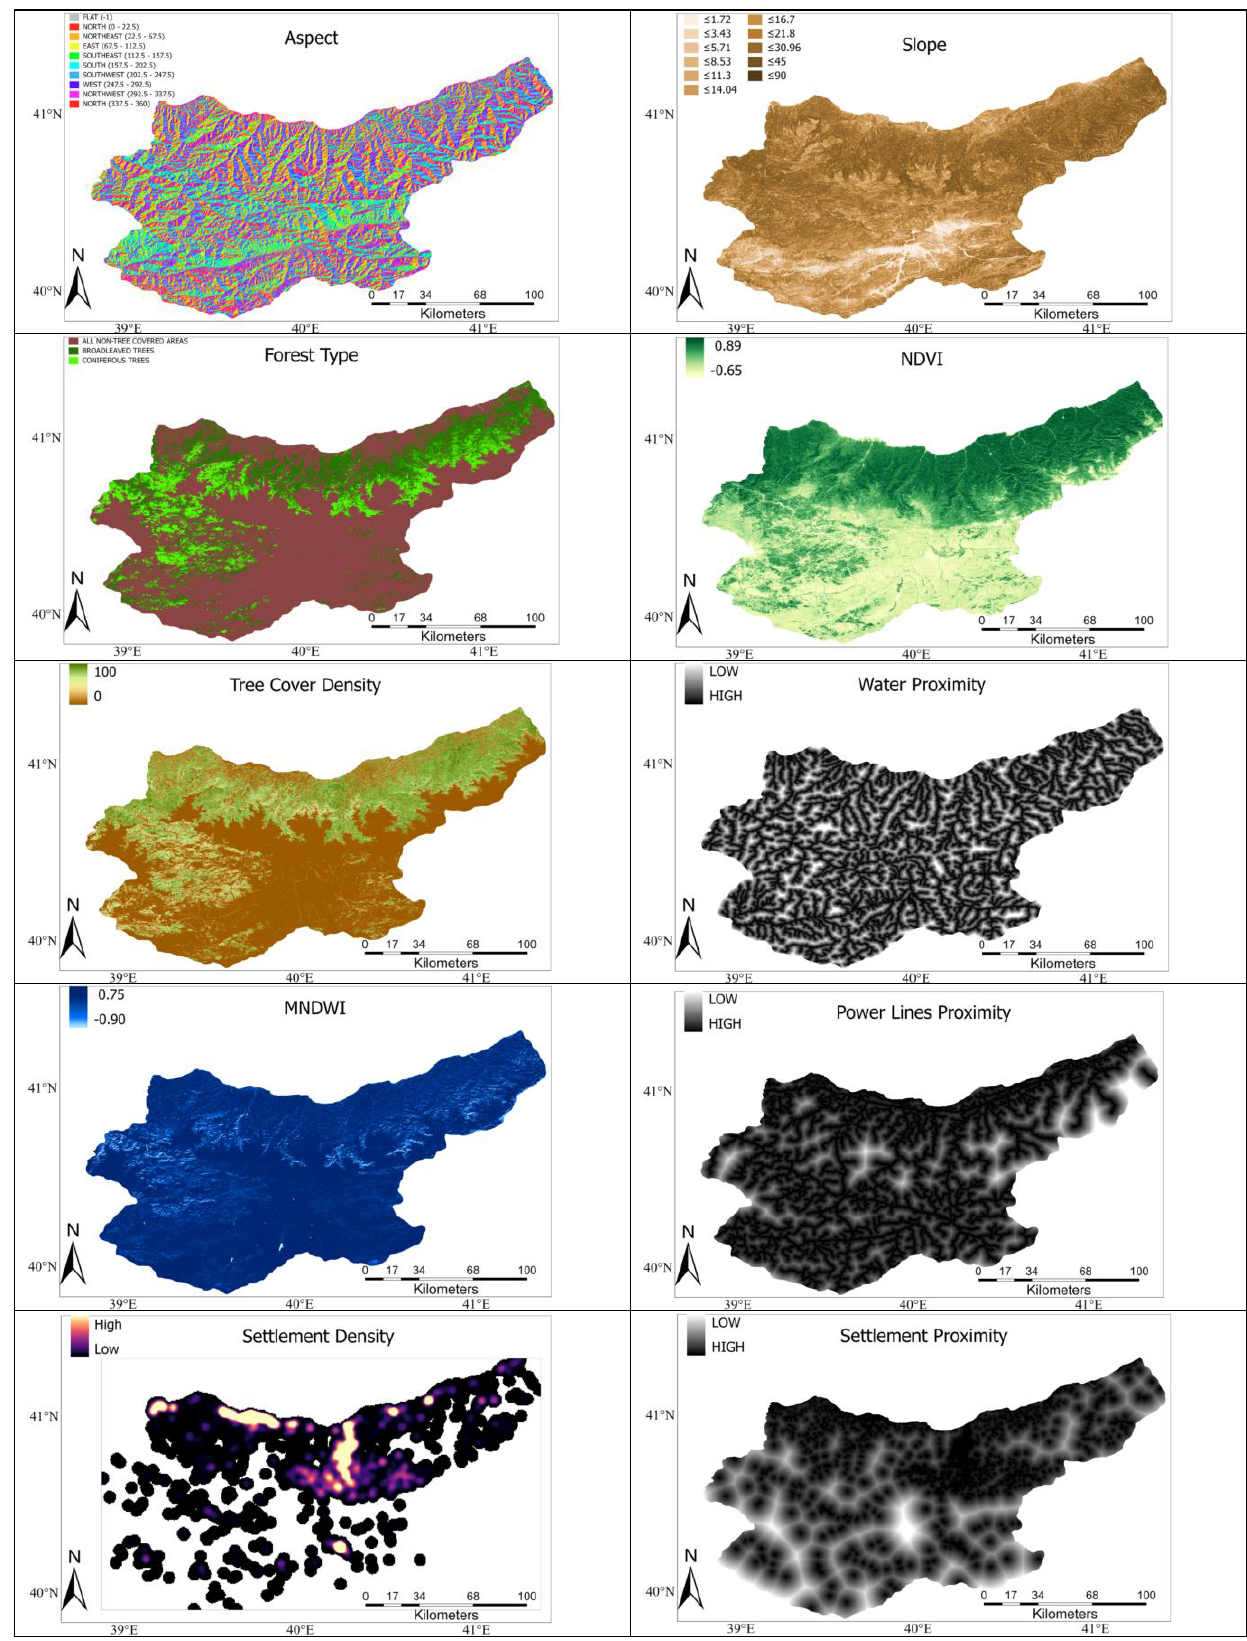
Figure A1 . Feature maps used in the